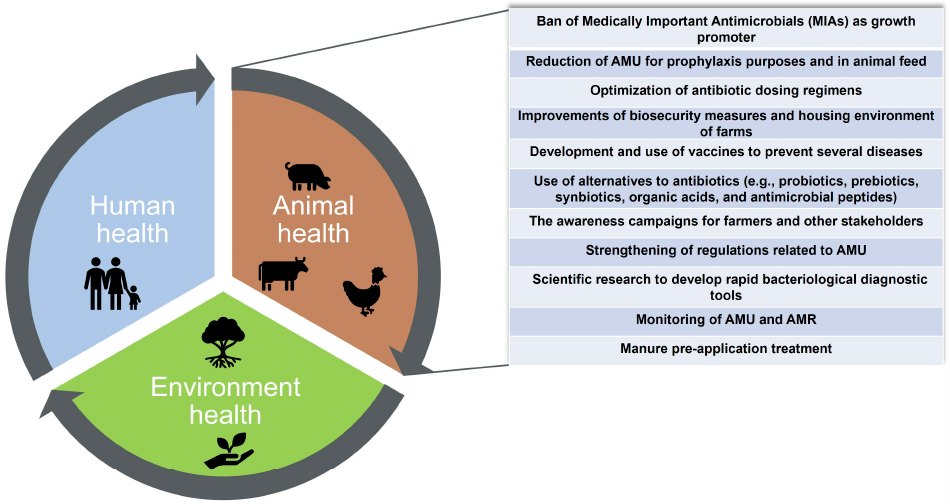
Figure 1. Actions conducted in livestock to tackle antimicrobial resistance from a One Health perspective. AMR, antimicrobial resistance; AMU, antimicrobial